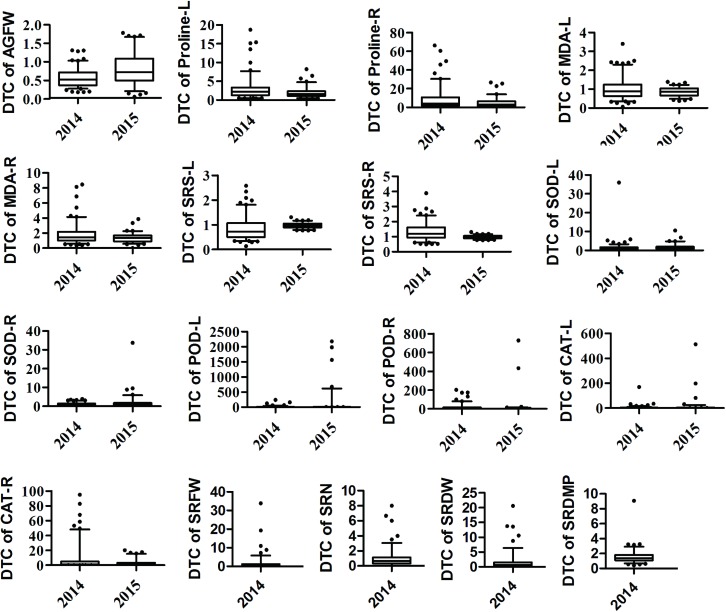
Boxplots of DTCs of cassava germplasm phenotypes in water stress experiments.